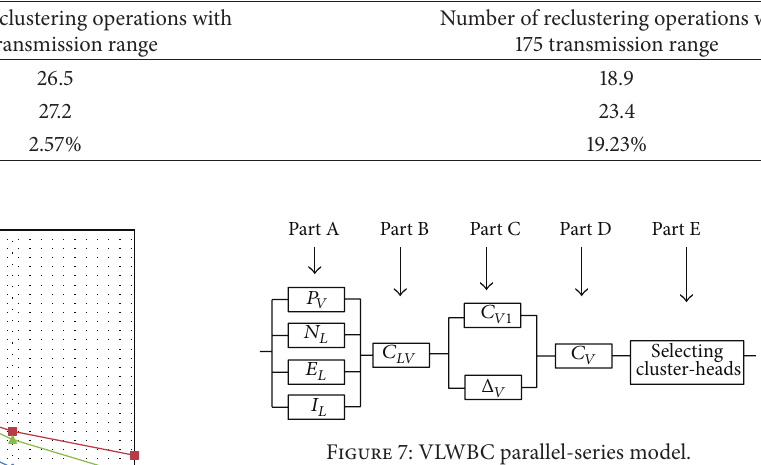
Table 5: Comparison of clustering and reclustering operations.